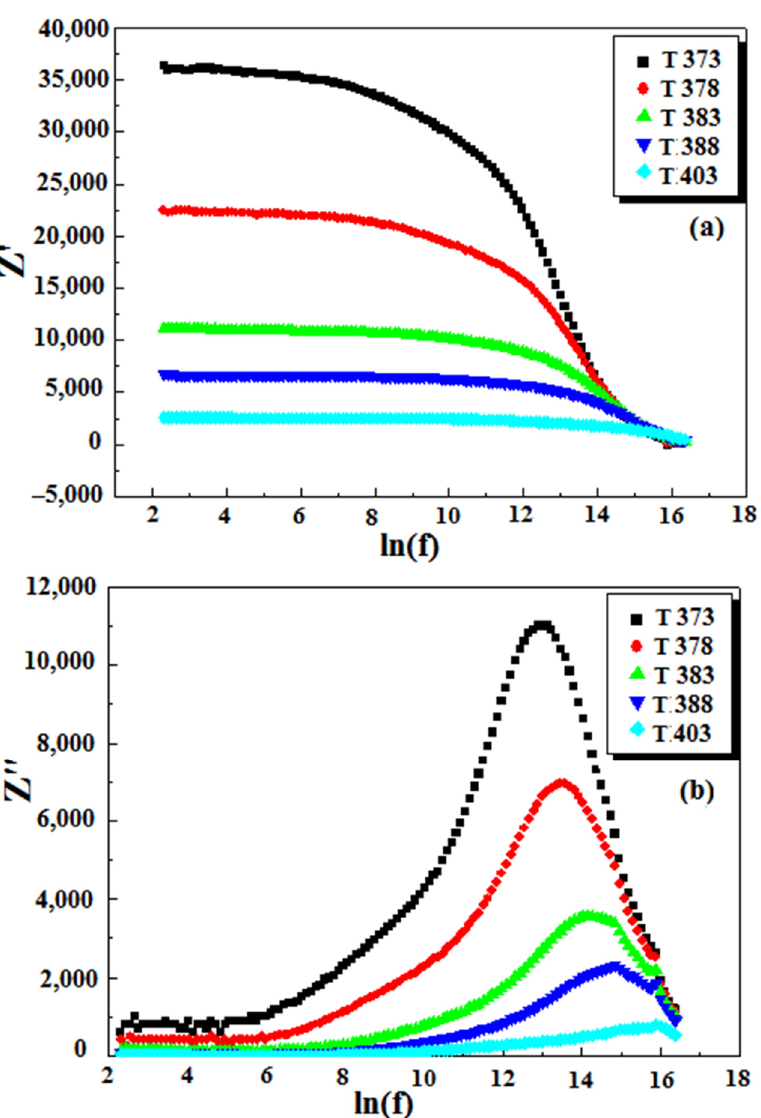
Figure 14. ( a ) Z’ (real part of impedance) versus ln(f) in the range of 373–403 K